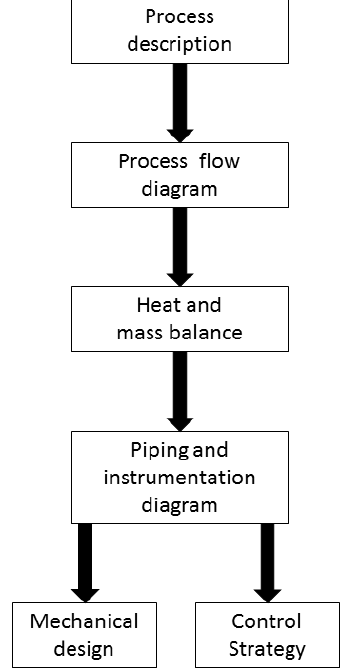
Figure 8. Design Figure 8. Design process.